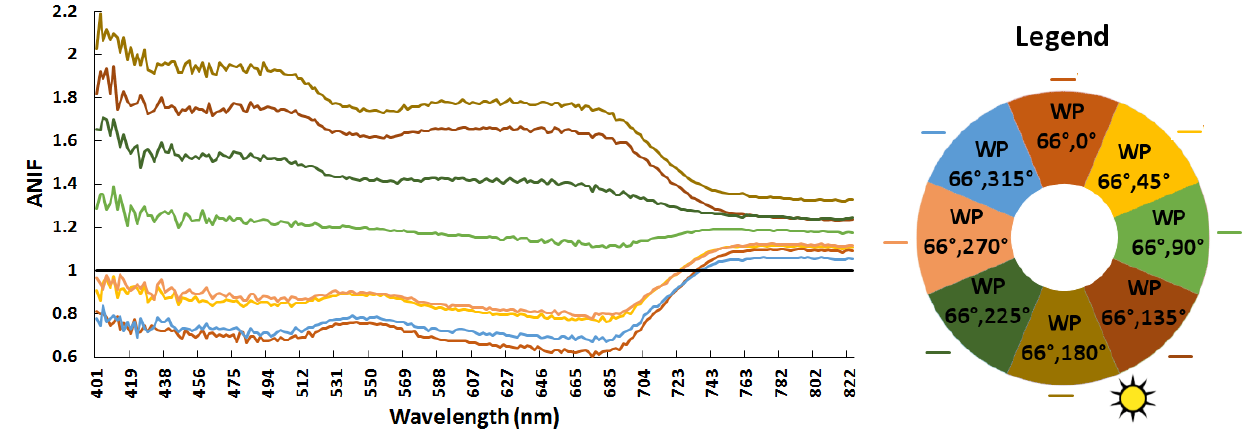
Figure 7. To present the angular influence at different waypoints on the full spectrum the normalized nadir anisotropy factor (ANIF) of 66° tilt for all headings at MERZ1 from 400 to 823 nm is plotted as example. By using the ANIF notation spectral deviation of single waypoints is referred to the nadir waypoint and thus can be relatively compared. A waypoint with the same spectrum as nadir would remain at an ANIF of 1 throughout all wavelengths. The legend on the right represents the color of each ANIF curve and depicts their respective heading angle. The azimuth position of the sun (155°) is visualized by the sun symbol. This shape of the ANIF which was observed for the 66° sensor tilt angle can also be found for the other tilt angles used in the overflights. Figure 8 shows the ANIF for five regions of the spectrum for all investigated tilt and heading angles. For all wavelengths the ANIF decreases with increase of the tilt angle. Only for most of the VIS region with heading from 180° to 270° the ANIF is smaller in the 43° tilt than in the 66°. On average the reflectance of the 135° and 180° show the highest increase from nadir with 191% and 181%, respectively. Lower reflectance values than in nadir are seen in the VIS spectral region with headings of 0°, 45°, 270° and 315°. At 0° and 315° even the average of all tilt reflection values is lower than in